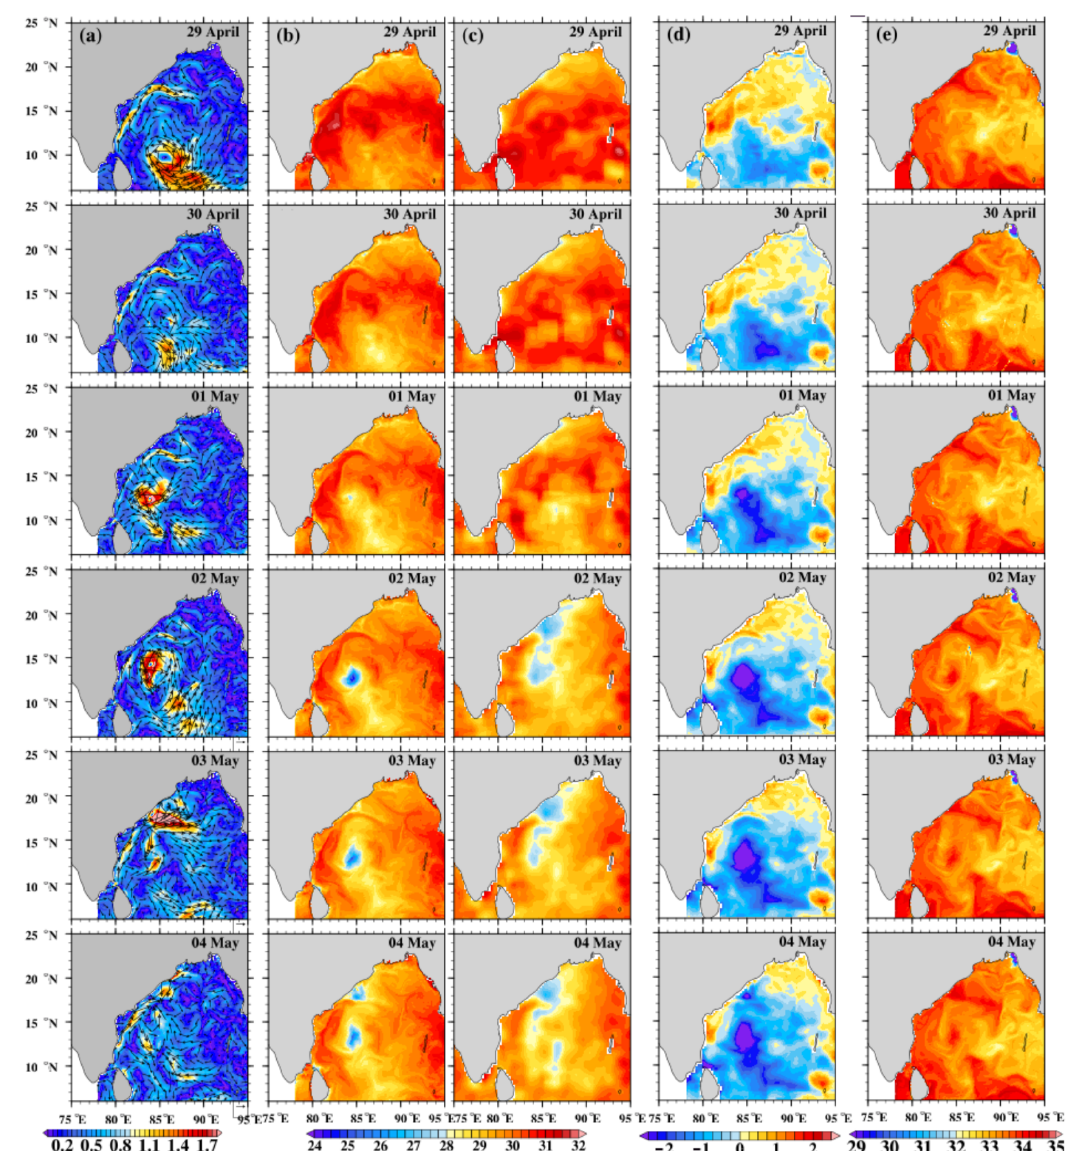
Figure 6. At 00 GMT each day: ( a ) model-computed surface current (m/s), ( b ) model-computed sea surface temperature ( ◦ C), ( c ) observed sea surface temperature from GHRSST, ( d ) difference (model–observation) in sea surface temperature, and ( e ) model-computed sea surface salinity